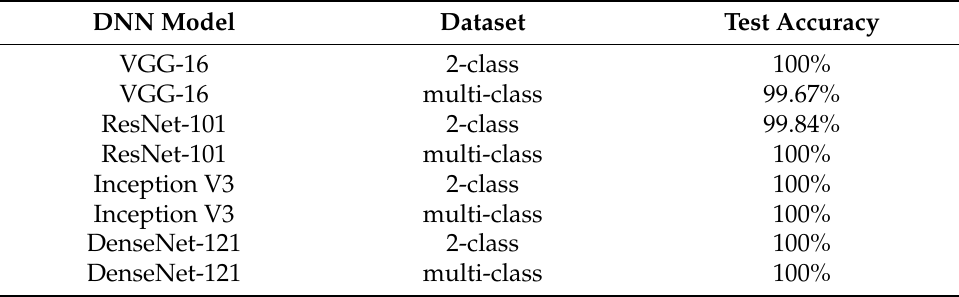
Table 2. Performance of fine-tuned DNN models without adversarial